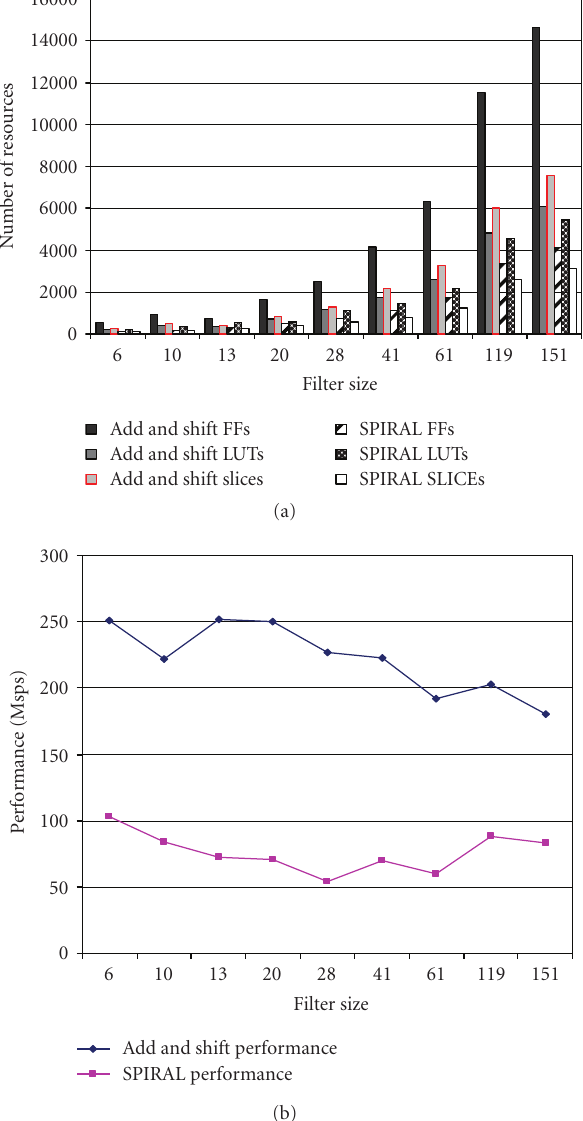
Figure 14: Resource utilization and performance implementation results for various filters using add and shift method (this paper) relative to that of SPIRAL automatic software. SPIRAL shows a saving of 72% in FFs, 11% in LUTs, and 59% in slices at the cost of 68% drop in performance. (a) Resource utilization in terms of # of FFs, LUTs, and SLICEs. (b) Performance